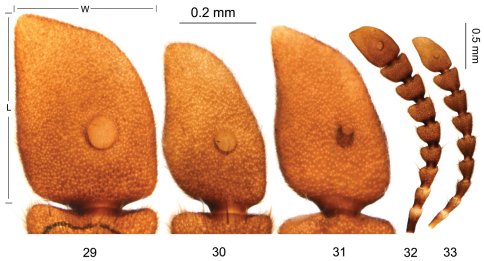
Male antennae in dorsal view, showing pit-like sensilla on terminal antennomere 29–31 terminal antennomere 29 Tillicera auratofasciata, from Guangxi 30 Tillicera sensibilis, sp. n., paratype 31 Tillicera wenii, sp. n., paratype 32–33 antennomere 3–11 32 Tillicera auratofasciata, from Guangxi 33 Tillicera sensibilis, sp. n., paratype.